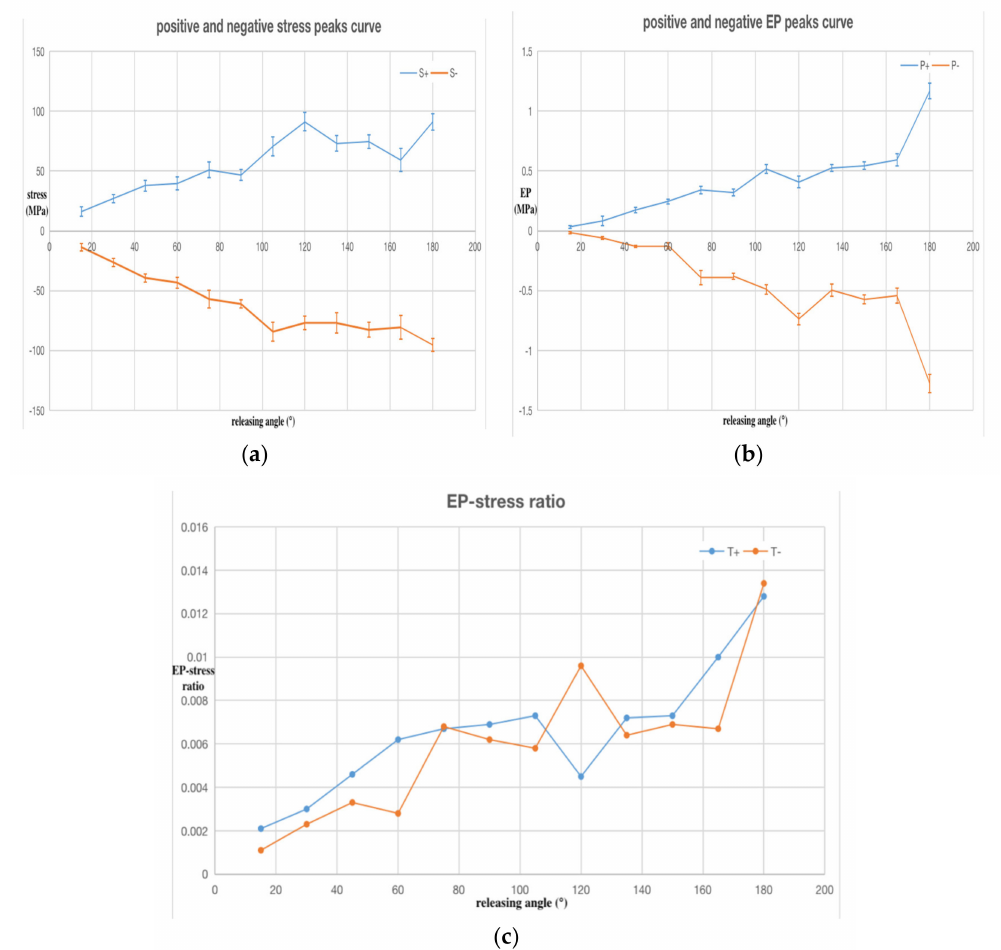
Figure 6. Analysis results of the SWE experimental data: ( a ) stress; ( b ) equivalent pressure (EP) of the PPS output; ( c ) EP–stress ratio. The ordinate unit of (c) is